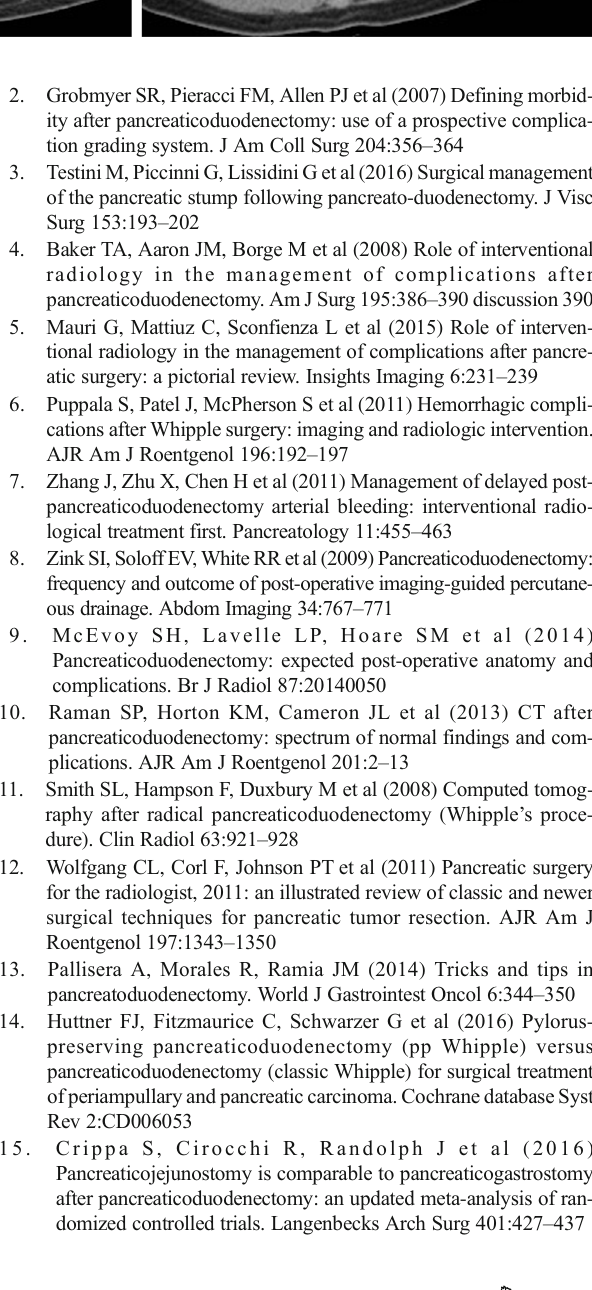
Fig. 14 Delayed postoperative acute pancreatitis in the same 59- year-old woman as in Fig. 6, after early PJS dehiscence and surgical reintervention. Nearly a month after PD, CT ( a ) showed fluid (*) collecting around the medium- sized and normally enhancing RP, which ultimately resolved at follow-up ( b ) with residual MPD dilatation. Note drainage tubes ( thick arrows ), air-containing MJL ( arrow in b